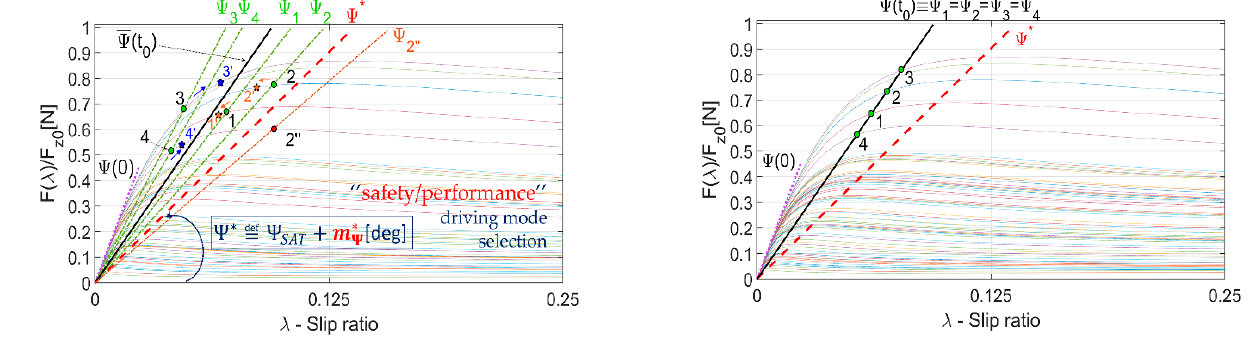
Figure 7. SV equalization.